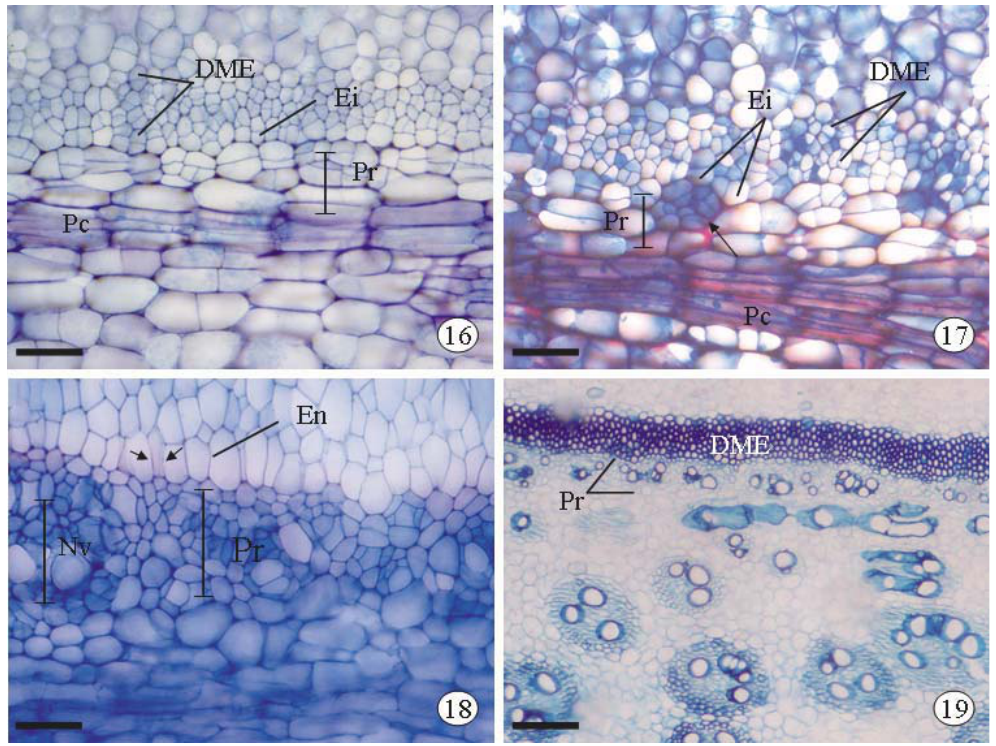
Fig. 16-19 – Cyperus papyrus . Longitudinal (16 and 17) and transverse sections of the rhizome (18 and 19). Fig. 16 – The endodermal initial (Ei) is still in the division phase, and the pericycle (Pr) presents divisions in Fig. 17, which evidence differentiation of a vascular bundle (arrow). Fig.18 – Observe the endodermis already in differentiation, and adjacent to it, a new vascular bundle (Nv) originating in the pericycle (Pr). The arrows indicate imperceptible Casparian strips. Fig. 19 –All of the inner cortex is thickened and the pericycle gives origin to bundles. DME – Derivatives of the Meristematic Endodermis. Pc – procambium. Rc – rhizome cortex; Vc – vascular cylinder. The bars correspond respectively to: 100 µ m, 100 µ m, 50 µ m and 400 µ